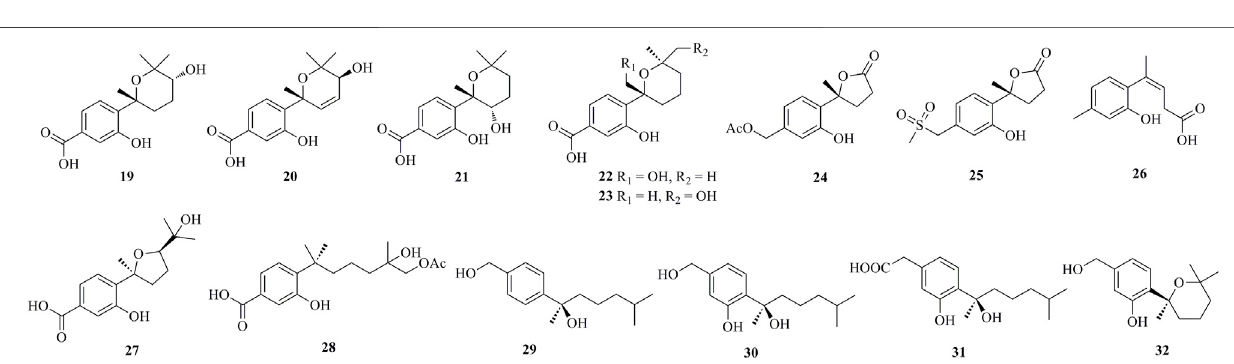
FIGURE 2 | Bisabolanes characterized from marine-derived fungi (Continued) ( 19 – 32 ).